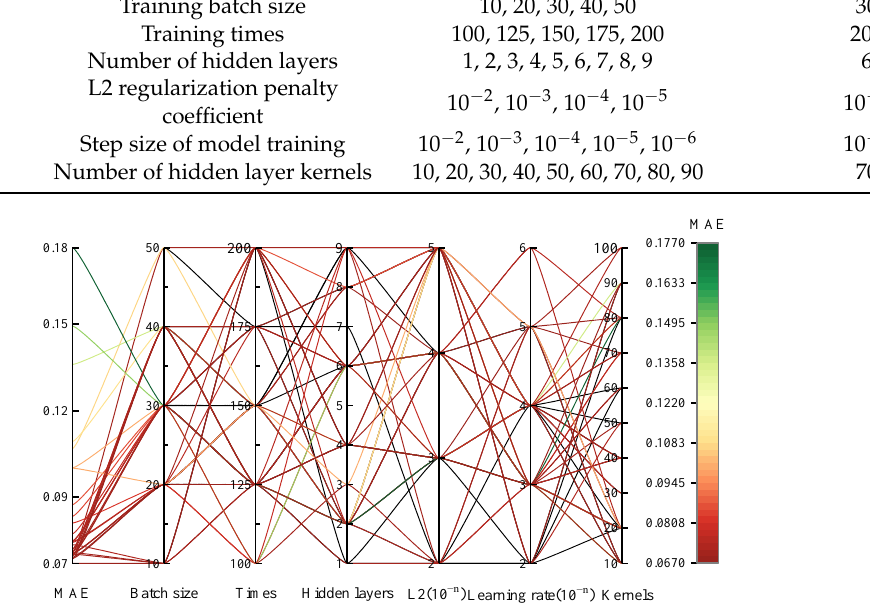
Figure 8. Optimization of DNN hyperparameters.